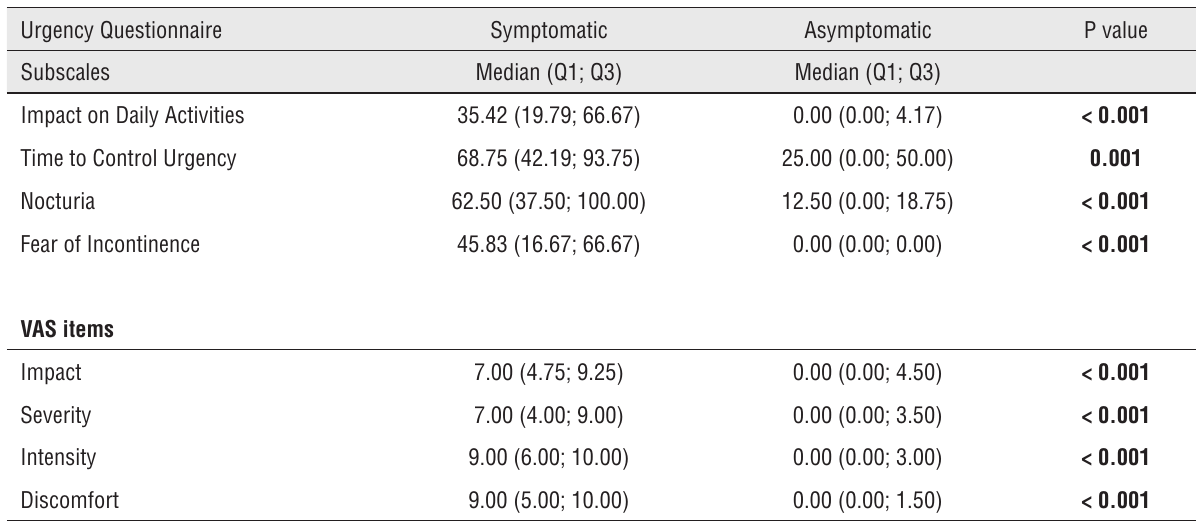
Table 2 - Comparative studies of the UQ subscales and vAS items between symptomatic and asymptomatic patients. Urgency Questionnaire